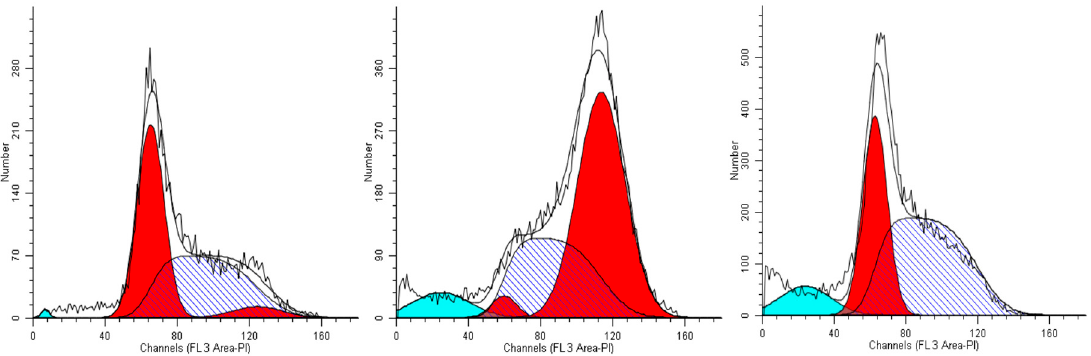
Figure 6. The cell cycle profiles of untreated U-937 cells (controls, left ), and cells incubated for 24 h in media containing 0.15% ( v / v ) of extracts #46 ( middle ) and #57 ( right